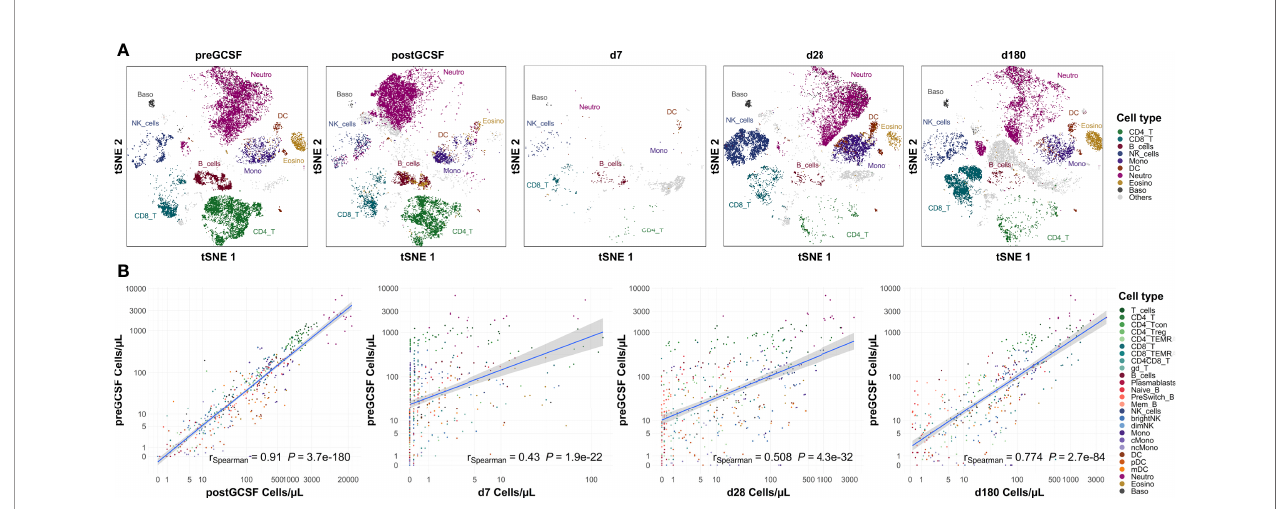
FIGURE 4 | Subset distribution approaches that of healthy donors on day +180 post transplantation. (A) Representative t-sne plot of measured subsets of a healthy donor before G-CSF stimulation. (B) Spearman correlation of cell counts of healthy donors before G-CSF stimulation (n=18) with those after G-CSF stimulation (n=21) and days +7 (n=20), +28 (n=21) and +180 (n=19) after transplantation. Correlation coef fi cients and p-values are shown in the graphs. Positive correlation indicates similar subset distribution as that of reference timepoint (healthy donors before stimulation). T_cells, T cells; CD8_T, CD8 T cytotoxic cells; CD8_TEMRA, CD8 terminally differentiated memory T cells; CD4_T, CD4 T helper cells; CD4_Treg, Regulatory CD4 T cells; CD4_Tcon, Conventional CD4 T cells; CD4_TEMRA, CD4 terminally differentiated memory T cells; CD4CD8_T, CD4CD8 double positive T cells; gd_T, gamma-delta T cells; B_cells, B cells; Naive_B, Naive B cells; NonSwitch_B, Non-switched memory B cells; Mem_B, Memory B cells;